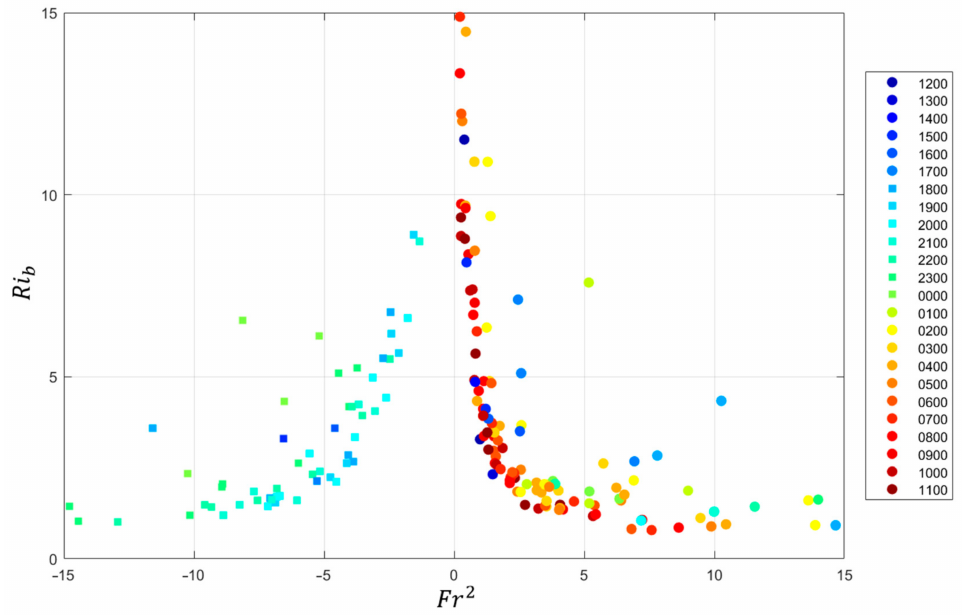
Figure 14. All WRF runs: Fr 2 vs. Ri b